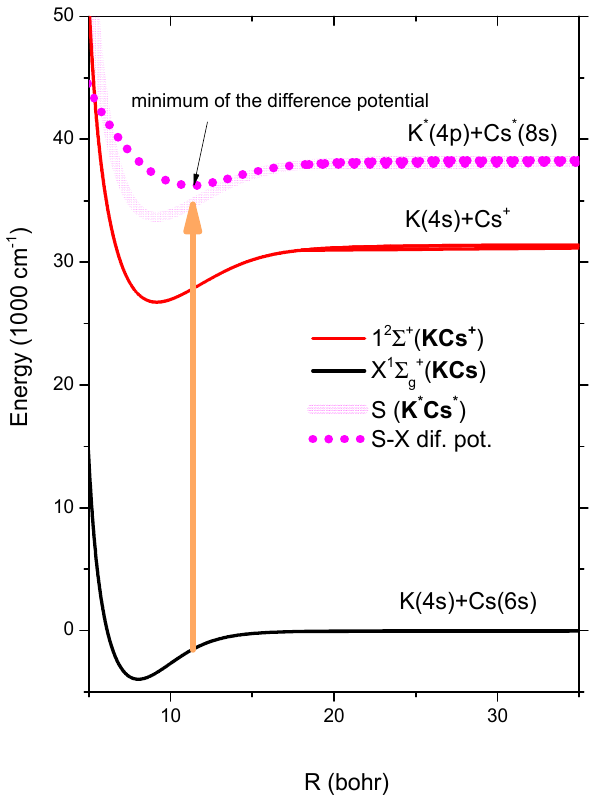
Figure 4. The ground state of the KCs + molecule (red) and the sketch of an artificially constructed, doubly excited state (DES of KCs ** denoted by S) with the asymptote K * (4p) + Cs * (8s), lying above the lowest KCs + potential curve. The minimum of the relevant di ff erence potential of the transition S(KCs ** ) -X(KCs) (magenta color) points to the location of the one possible photoionization